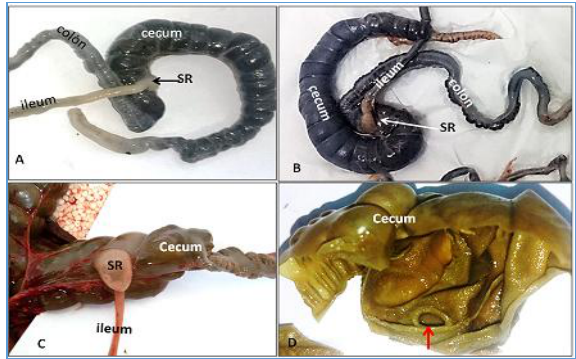
Figure, 1: Hind gut of rabbit showing the development of SR at 10 days (A), 15 days (B) and 40 days (C). D: represent the opening of SR within cecum (red